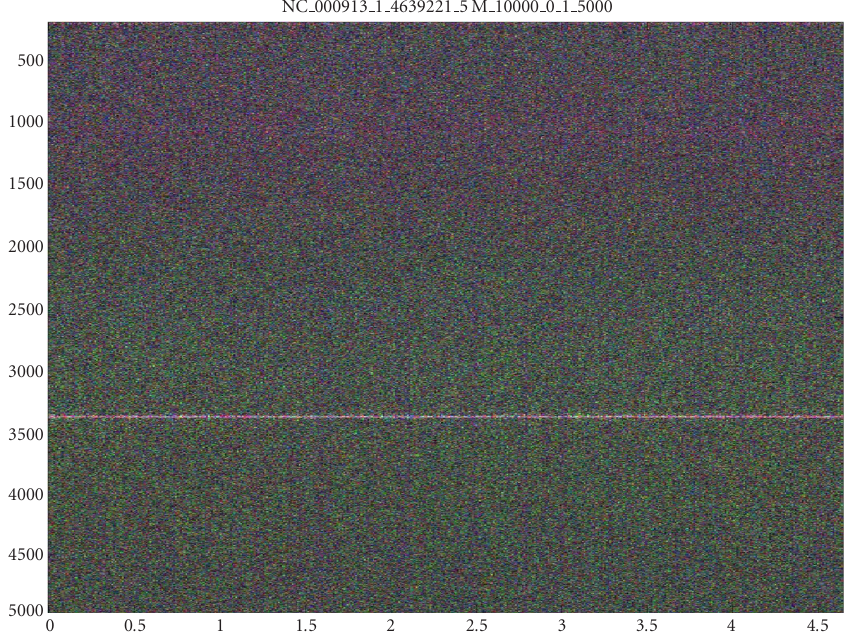
Figure 3: Spectrogram of the entire E. coli K12 chromosome (about 4.6 Mbp). The line marking the 3-base periodicity of protein-coding regions extends without a visible break across the entire chromosome. There is a change in color going from higher frequencies (greenish) to lower frequencies